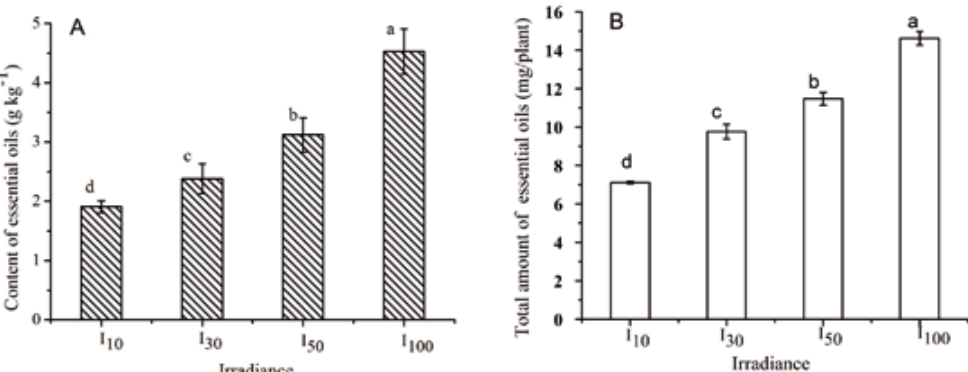
Fig. 5: The content of essential oil (A) and the total amount of essential oil (B) in leaves of M. breviracema under different light intensities . The columns with different uppercase letters show obvious differences